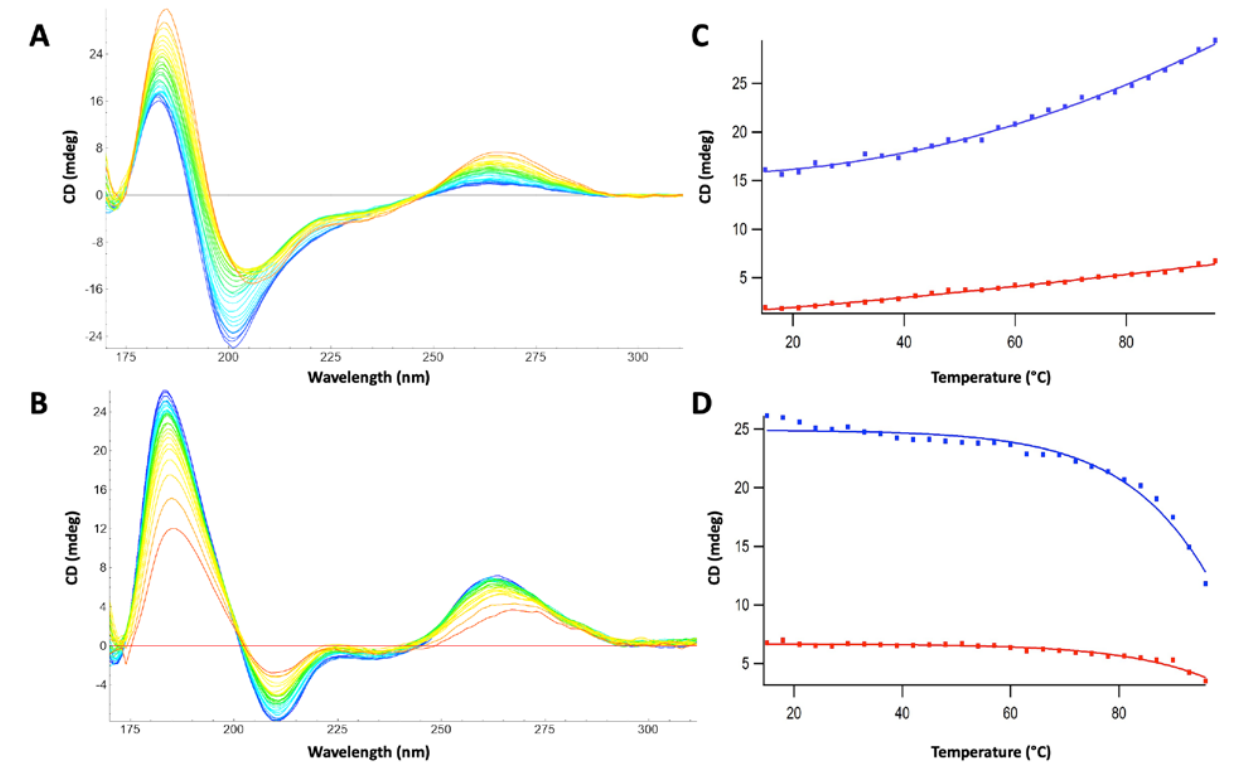
Figure 8. Melting curves of RNA I-RNA II complex in the presence of Hfq-CTR ( A ) or without Hfq-CTR ( B ). The increase in CD signal, in particular at 188 nm, indicates that RNA I-RNA II complex is considerably more stable in the presence of Hfq-CTR at high temperatures ( C ). This is not the case for RNA I-RNA II complex without CTR, which melts at increasing temperatures ( D ). Blue curves show CD signal at 188 nm; red curves are at 275 nm. The T m of RNAI:RNAII duplex (without CTR) is estimated ~110 ◦ C, which is remarkably high. As for Figures 3 and 4A, SRCD values in Figures 7 and 8A cannot be compared due to molecular alignment and the influence of the SRLD